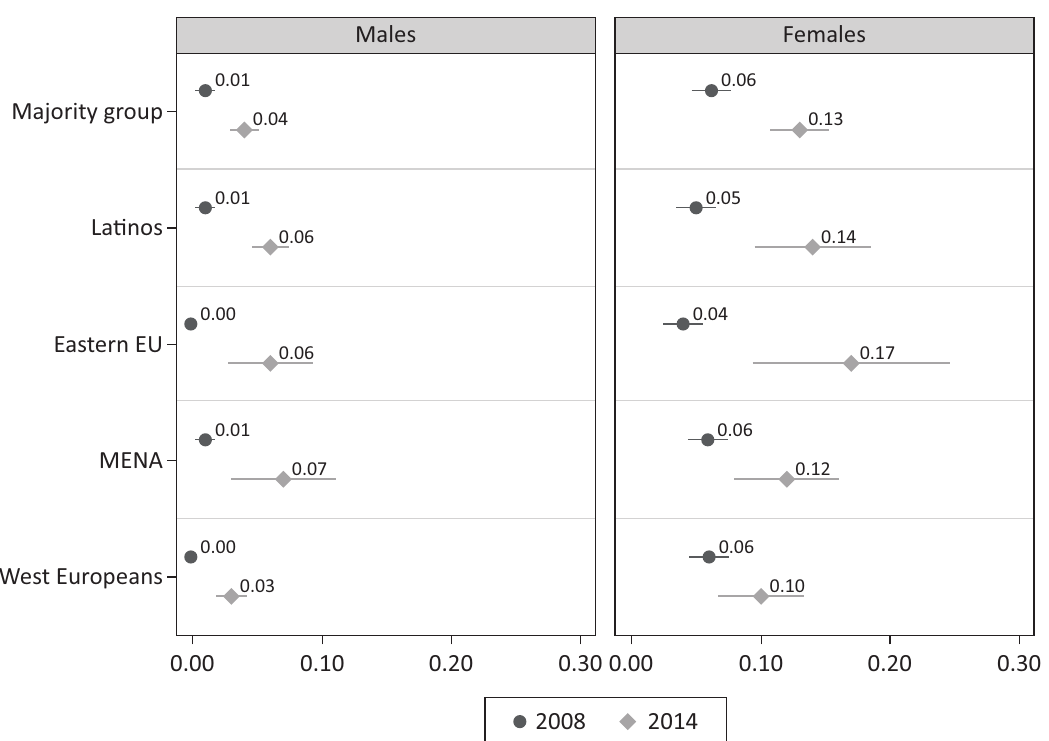
Figure 2. Predicted probabilities for involuntary part-time work across ethnicities in 2008 and 2014. Notes: Controls for first generation, age, education, social class, civil status, dependent children and degree of urbanisation; N = 77,284 (only working sample); age 16–64, not in education/training or retired; bars represent 90% confidence intervals; weighted and clustered by